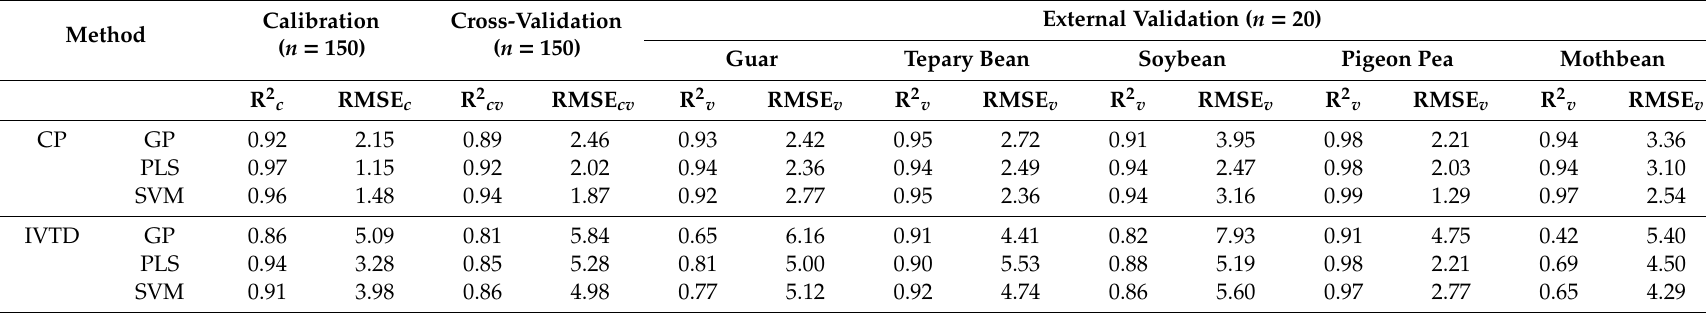
GP, Gaussian processes; PLS; partial least square; SVM, support vector machine; R 2 c , determination coe ffi cient in calibration; RMSE c , root mean square error in calibration; R 2 cv , determination coe ffi cient in cross-validation; RMSE cv , root mean square error in cross-validation; R 2 v , determination coe ffi cient in external validation; RMSE v , root mean square error in external